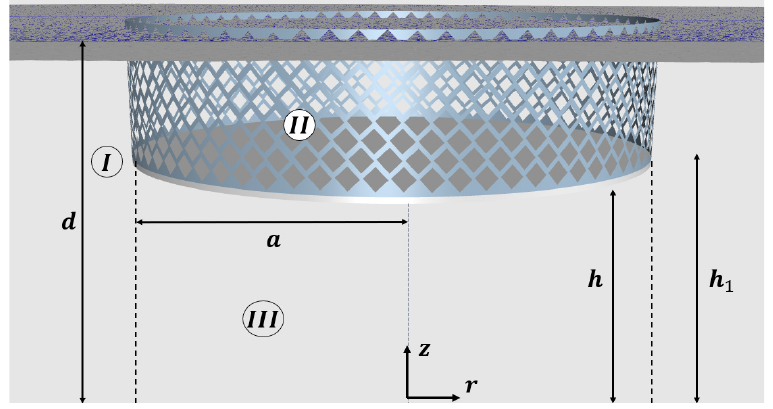
Figure 1. A 3D representation of the examined permeable vertical cylindrical body.